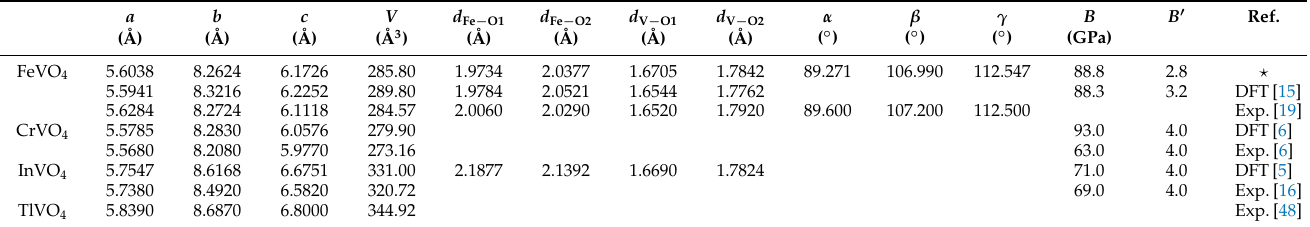
Table 1. Calculated structural parameters for FeVO 4 - II phase. a , b , and c are the lattice parameters, V is the volume, d X − O n ( X = Fe, V; n = 1, 2) and α , β , and γ , are the interatomic distances and angles inside the crystal structure, respectively (see Figure 1). B is the bulk modulus and B (cid:48) is the pressure derivative of B . Results from this work are denoted with (cid:63) . We also include experimental results from the literature of A VO 4 compounds for